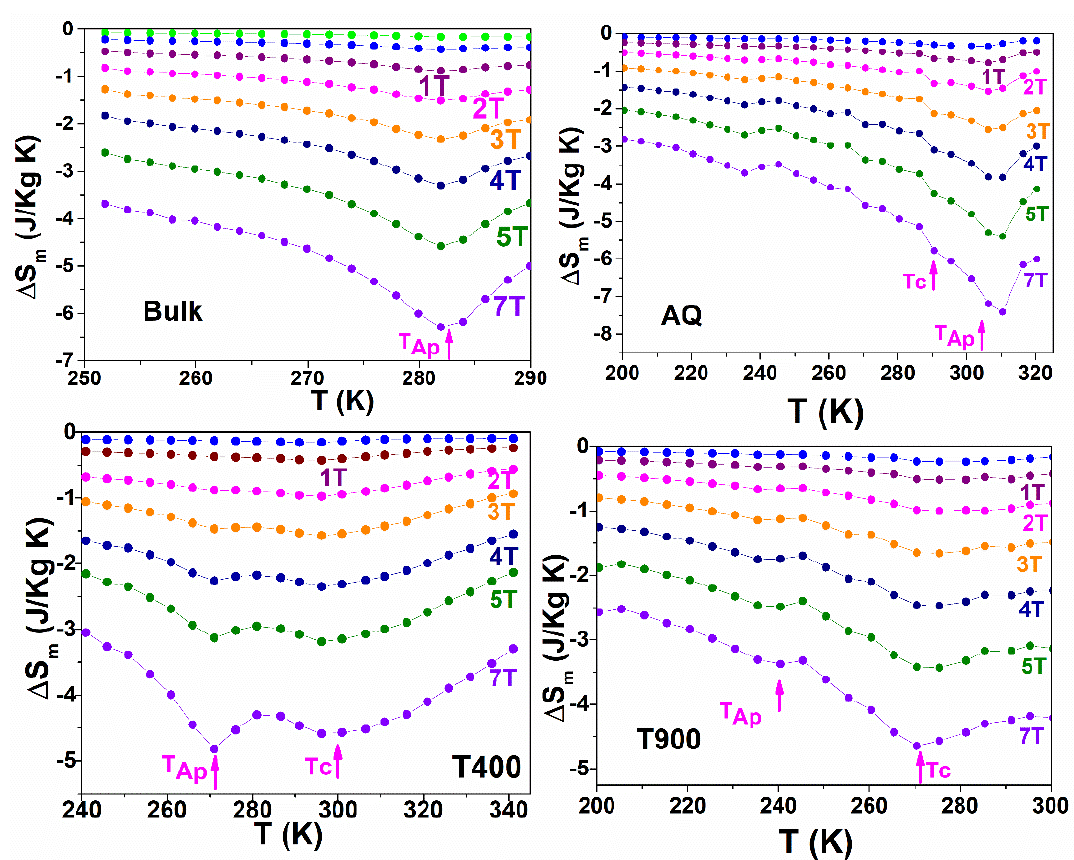
Figure 6. Magnetic entropy variation ∆ S m versus raising temperature.